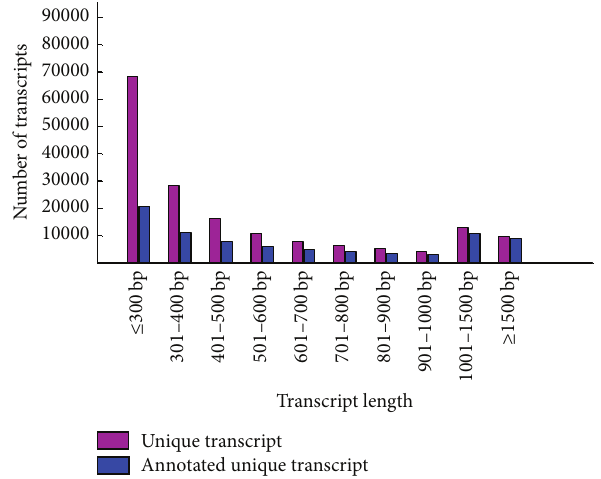
Figure 1: Length distribution of Thinopyrum elongatum unique